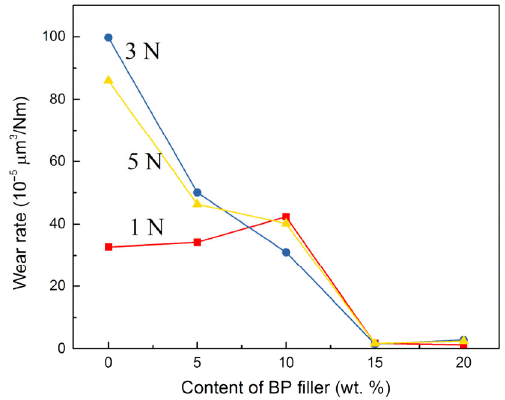
Fig. 36 Wear rate of BP/PVDF composites at different applied